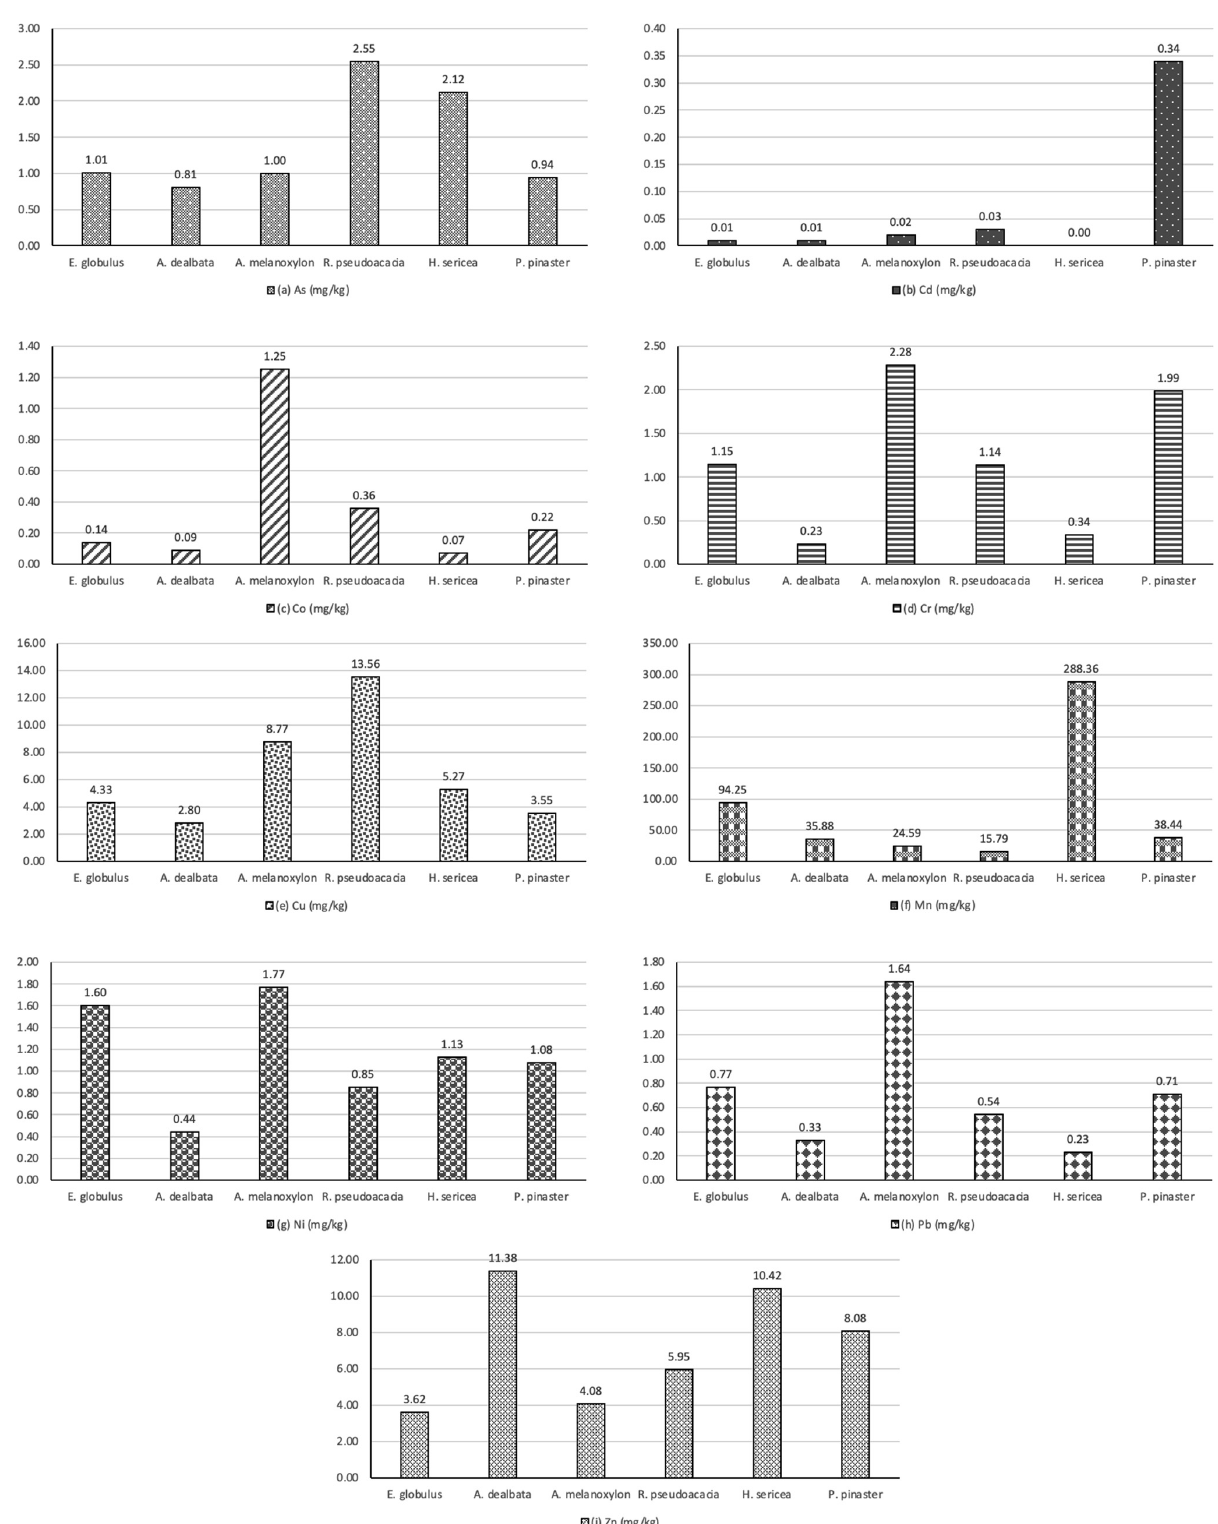
Figure 7. Content of minor elements.